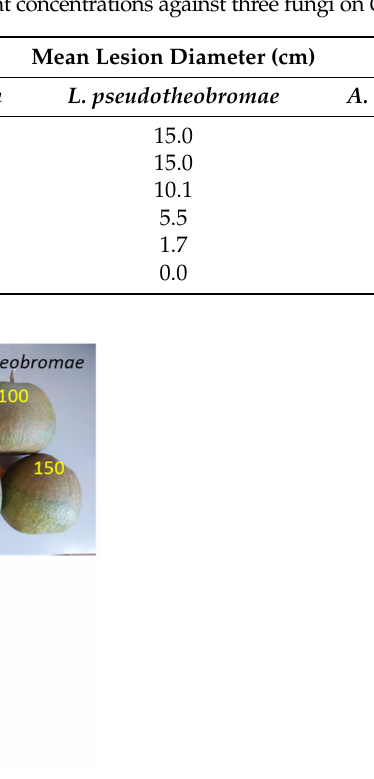
Table 1. The antifungal activity of SCNs at different concentrations against three fungi on Citrus maxima.